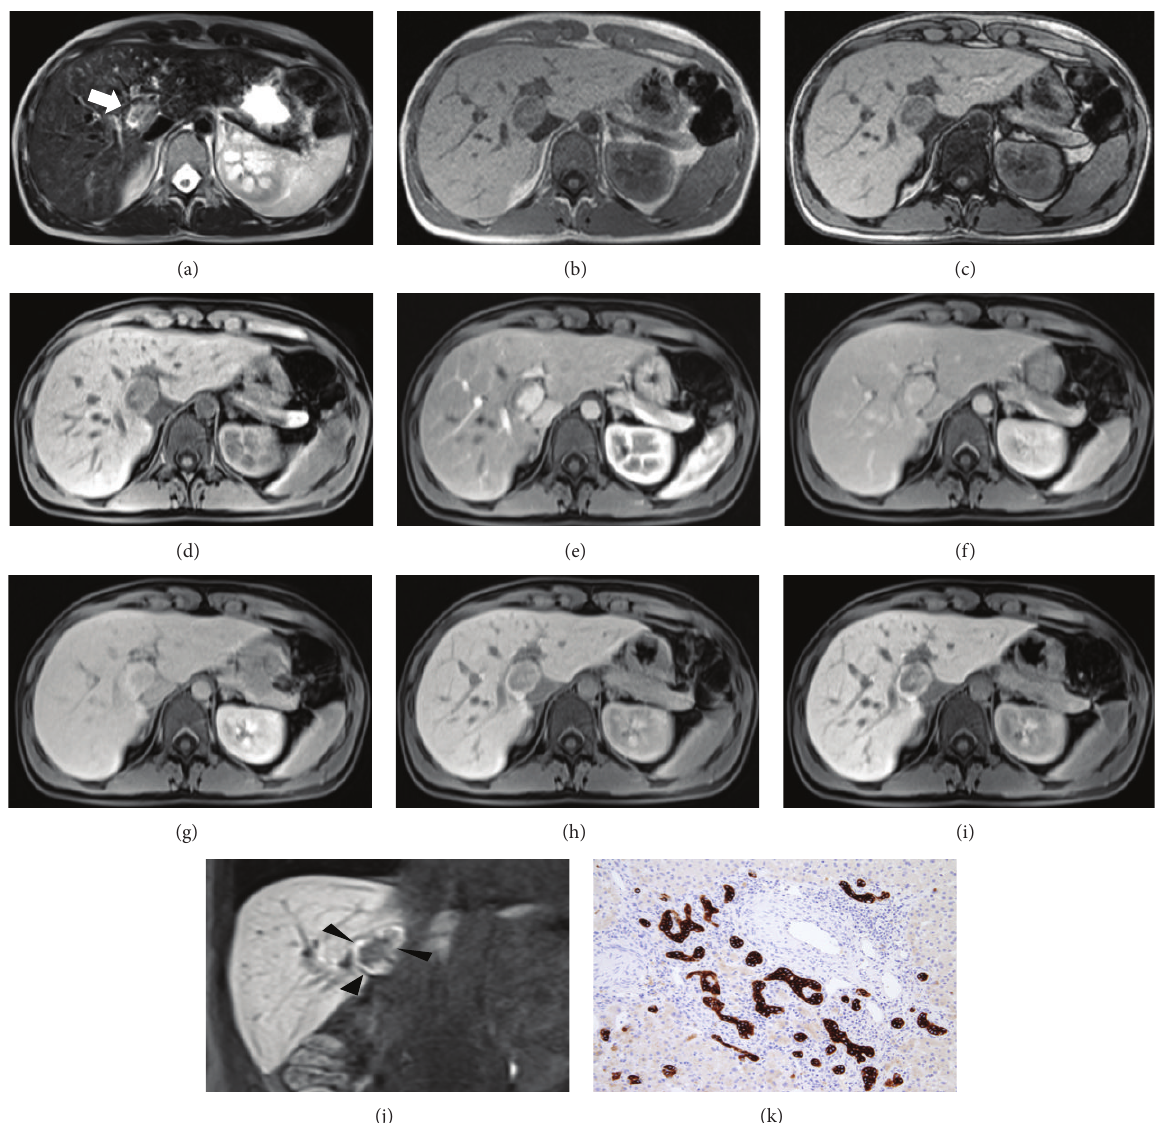
Figure 2: Inflammatory adenoma with “atoll sign.” (a) In S IX well-delineated slightly hyperintense lesion with hyperintense peripheral rim (arrow) in axial T2w image. (b-c) T1w in- and out-phased images. The mass is hypointense relative to the hepatic parenchyma with isointense rim. (d–h) In dynamic evaluation after Gd-EOB-DTPA administration the lesion shows marked central enhancement in arterial phase (e) with slight wash out in portal (f) and more evident equilibrium (g) phases. After 5 󸀠 (h) the nodule is mainly hypointense. Conversely, the peripheral component of the nodule demonstrates progressive enhancement over time. (i-j) In hepatobiliary phases after 20 󸀠 , axial (i) and coronal (j), the lesion is heterogeneously hypointense in the central portion and hyperintense at the periphery (arrowheads). Final diagnosis was obtained by biopsy. Histology demonstrates ductal reaction at the periphery of the lesion